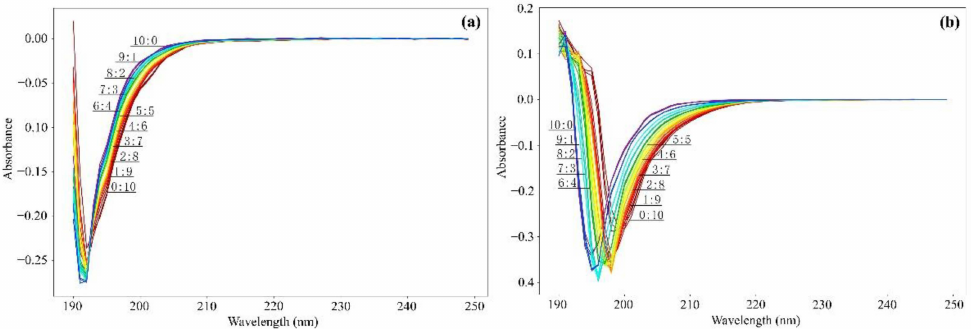
Figure 6. Smooth denoising diagram. ( a ) H-1 and H-2 mixed water sample spectrum, ( b ) H-3 and H-4 mixed water sample spectrum.